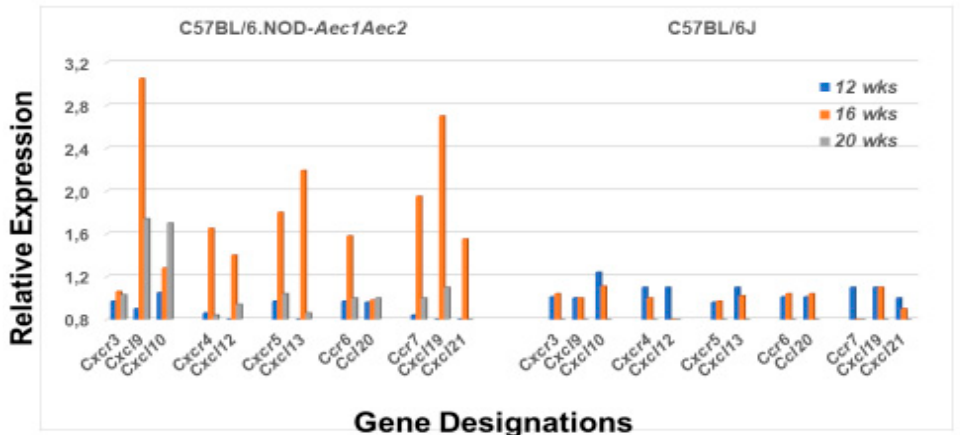
Figure 5. Differential expression profiles for genes encoding chemokine and chemokine receptors associated with MZB cell activity. Comparative transcriptome data showing the temporal expression of MZB cell-associated chemokine receptor (chemokine (CXC motif) receptor) genes ( Cxcr3 , Cxcr4 , Cxcr5 , Cxcr6 and Cxcr7 ) and their respective chemokine ligand (chemokine (CXC motif) ligand) genes ( Cxcl9, Cxcl10, Cxcl12, Cxcl13, Ccl20, Cxcl19 and Cxcl21 ) in salivary glands of SS S C57BL/6.NOD- Aec1Aec2 mice ( left ) versus SS NS C57BL/6J mice ( right